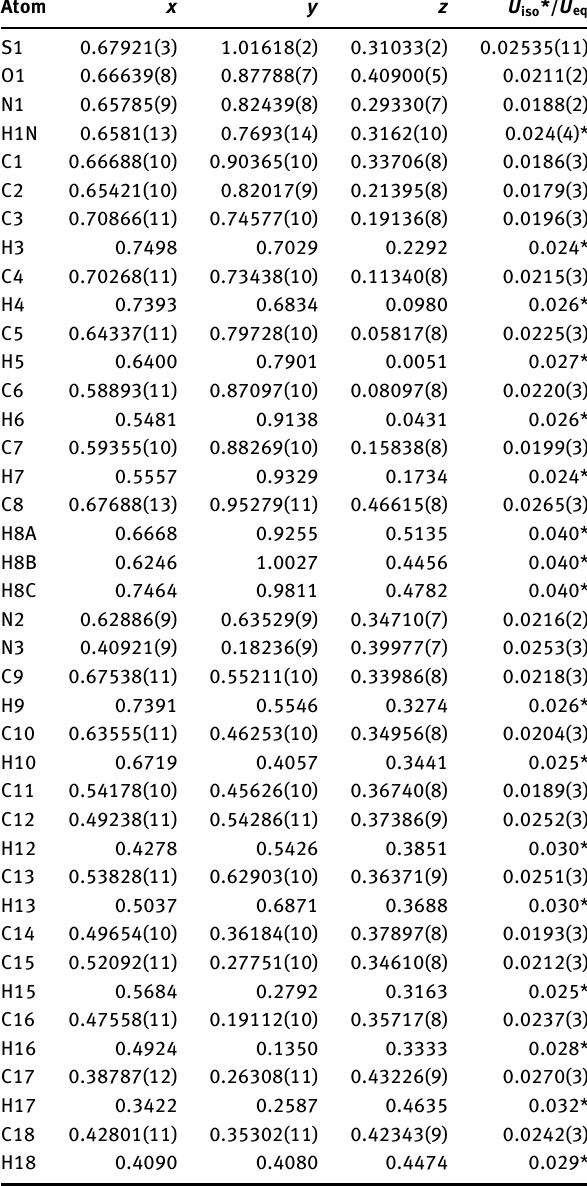
Table 2: Fractional atomic coordinates and isotropic or equivalent isotropic displacement parameters (Å 2